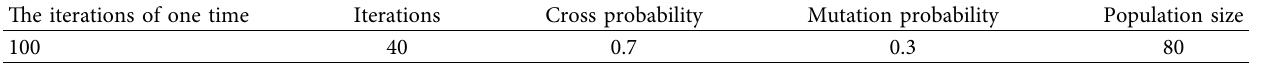
Table 3: Algorithm running parameters.